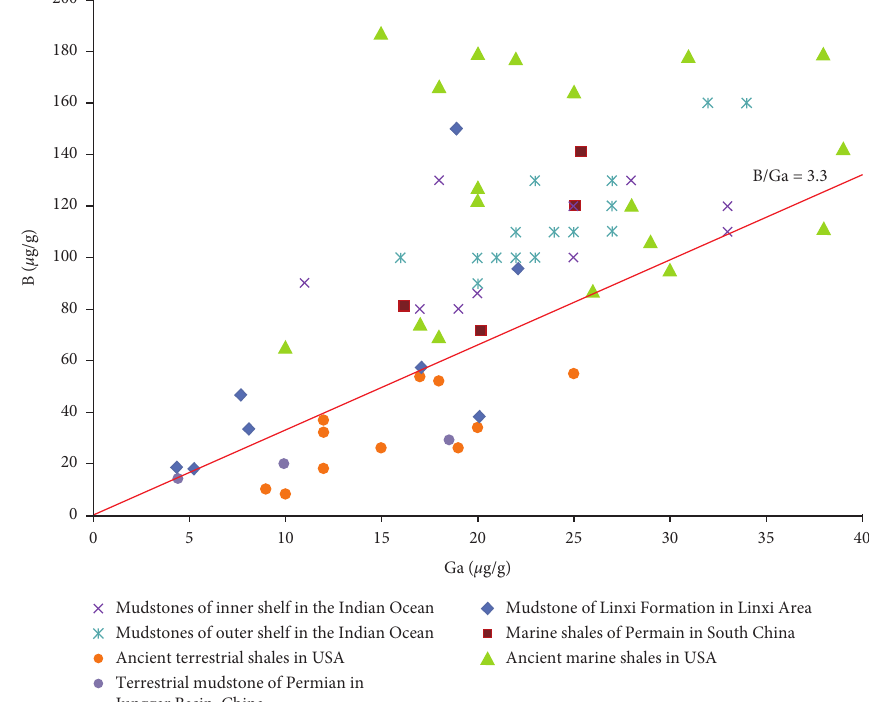
Figure 7: Relationship between the B and Ga contents of the Linxi Formation mudstone from the Linxi area Guandi profile in eastern Inner Mongolia and comparison with other regions of the